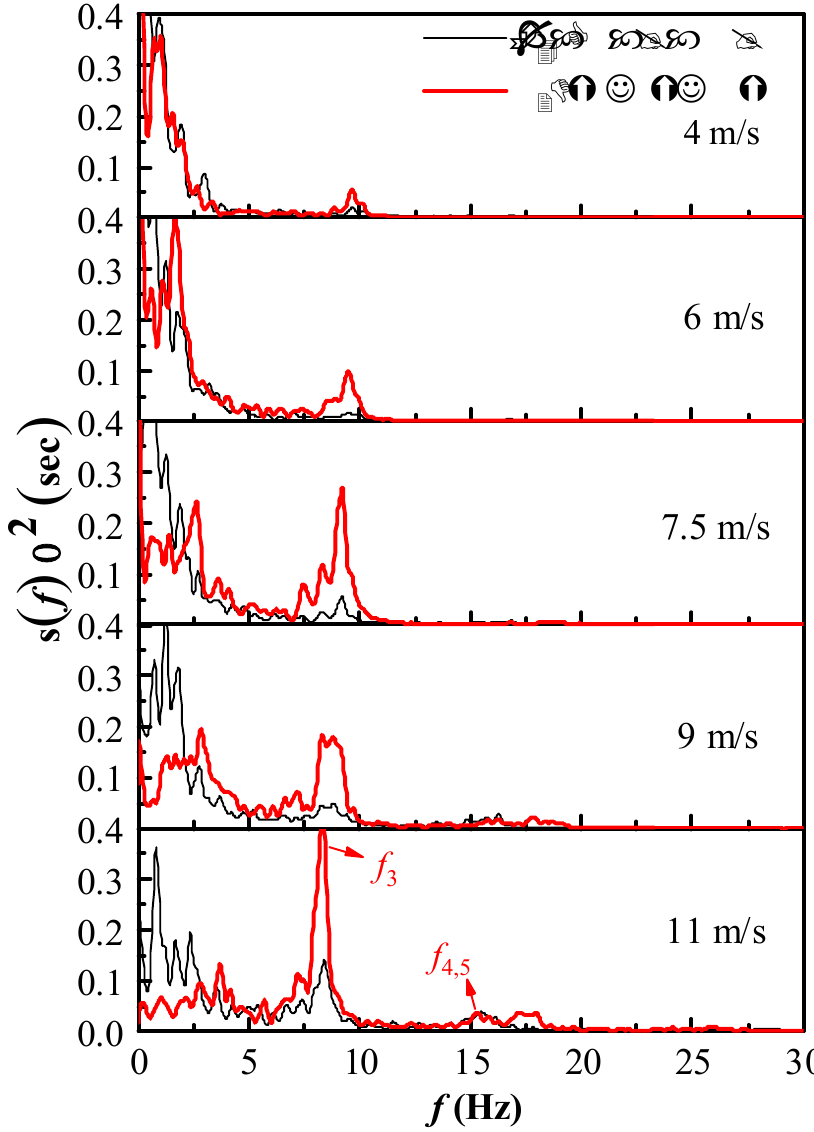
Figure 16. PSD of displacement at different wind